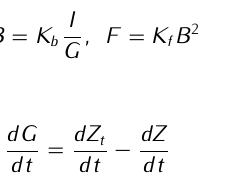
model, linearisation is done around the operating point using (5)-(7). The ‘o’ subscript defines the operating point and small letters the perturbation around the operating point. The linerization around the operating point is